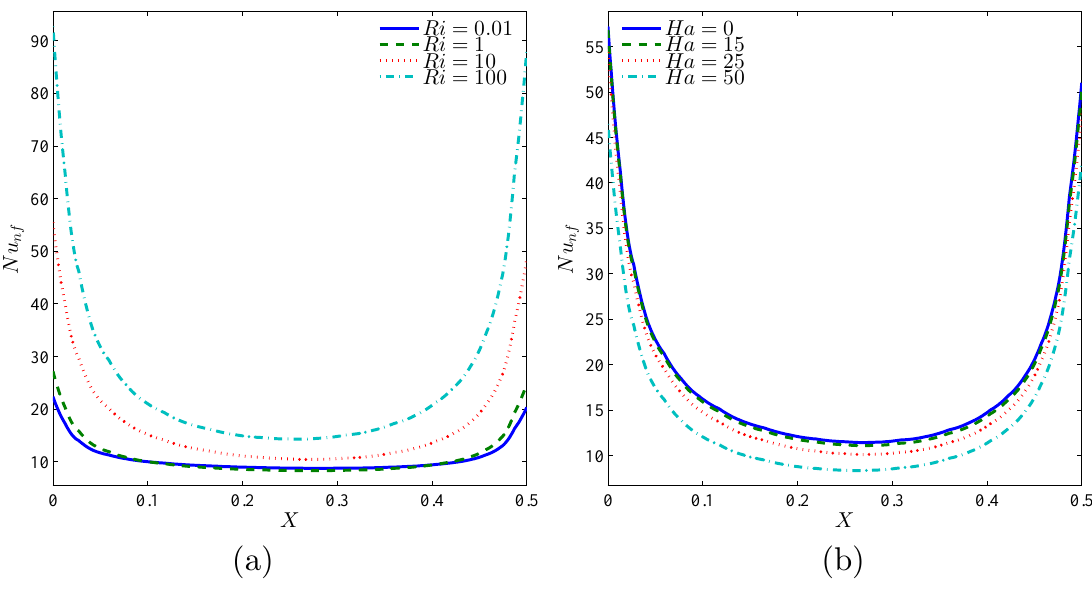
Figure 10. Plots of the local Nusselt number vs. X for different ( a ) Ri and ( b ) Ha at φ = 0.02 and D = 0.3.